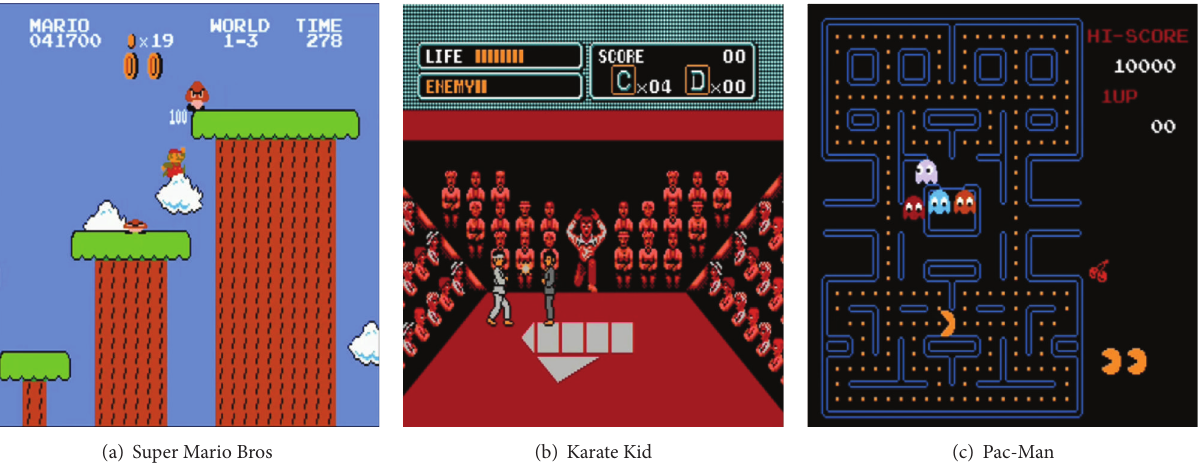
Figure 7: Examples of games available in the Learnfun & Playfun